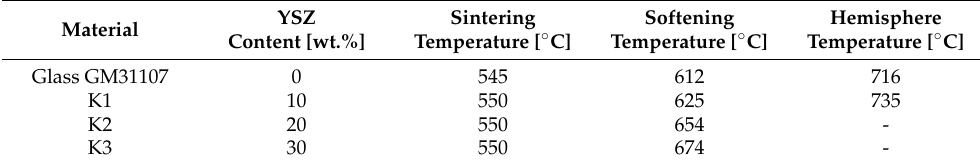
Table 1. High-temperature microscopy of Schott glass GM31107 and